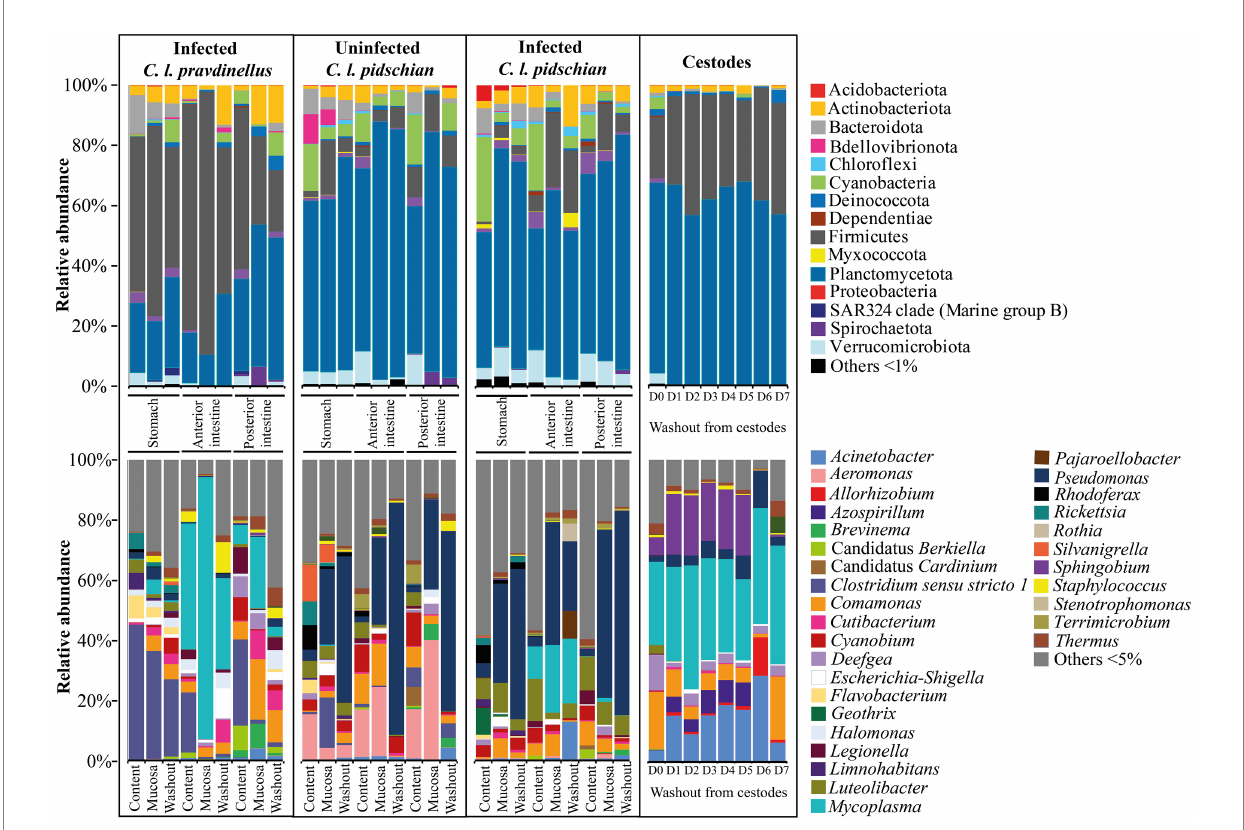
FIGURE 3 Dominant ASV at the phylum and lowest taxonomical level within the microbial communities from different segments of the digestive tract of whitefish and microbiota associated with cestodes parasitizing the intestine of “normal” C. l. pidschian